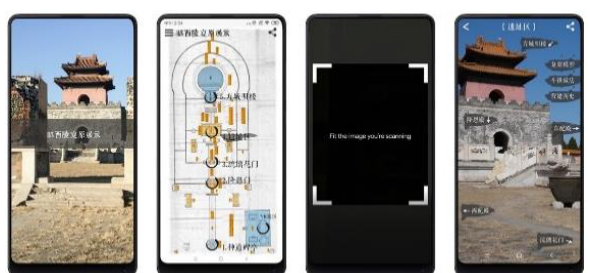
Figure 33. The welcome interface, the main interface, the scanning image interface, the interface within the scene.